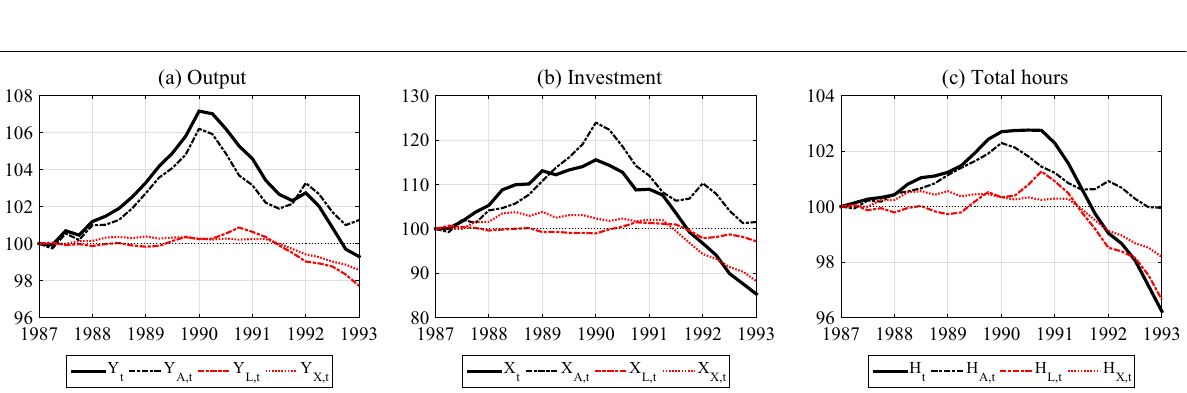
Fig. 14 Robustness: The 1987Q1–1993Q1 period for ν = 2 . The subscripts A , L , X denote the efficiency-, labour-, and investment-wedge-alone components of output Y t , investment X t , or total hours H